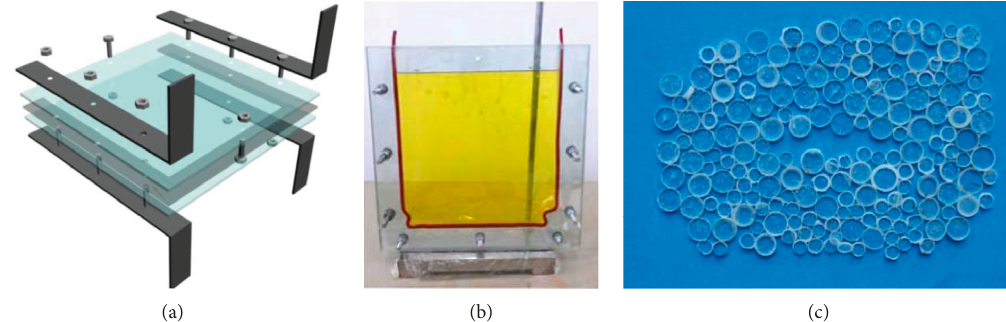
Figure 4: Experimental setup for the model fabrication. (a) Mold. (b) Molding. (c) Discs.